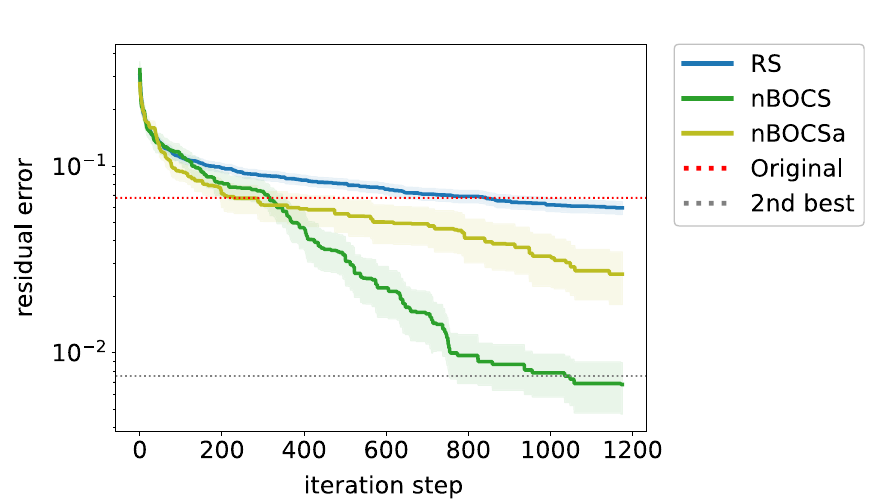
Figure 3. The residual error of lossy compression of a matrix for RS and nBOCS variants with and without data augmentation (nBOCSa and